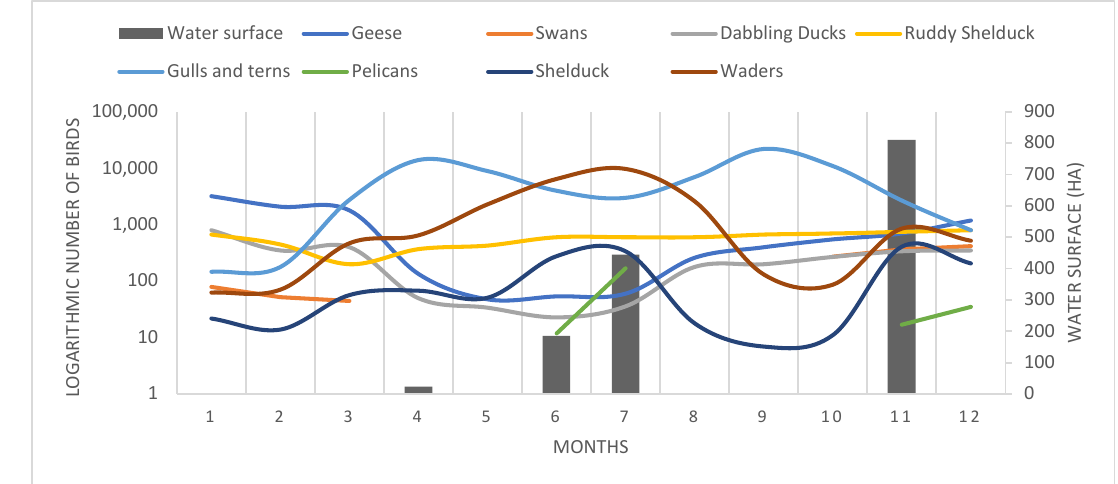
Land 2022 , 11 , x FOR PEER REVIEW Figure 7. Average number of birds per the months in 2020. Figure 7. Average number of birds per the months in 2020.